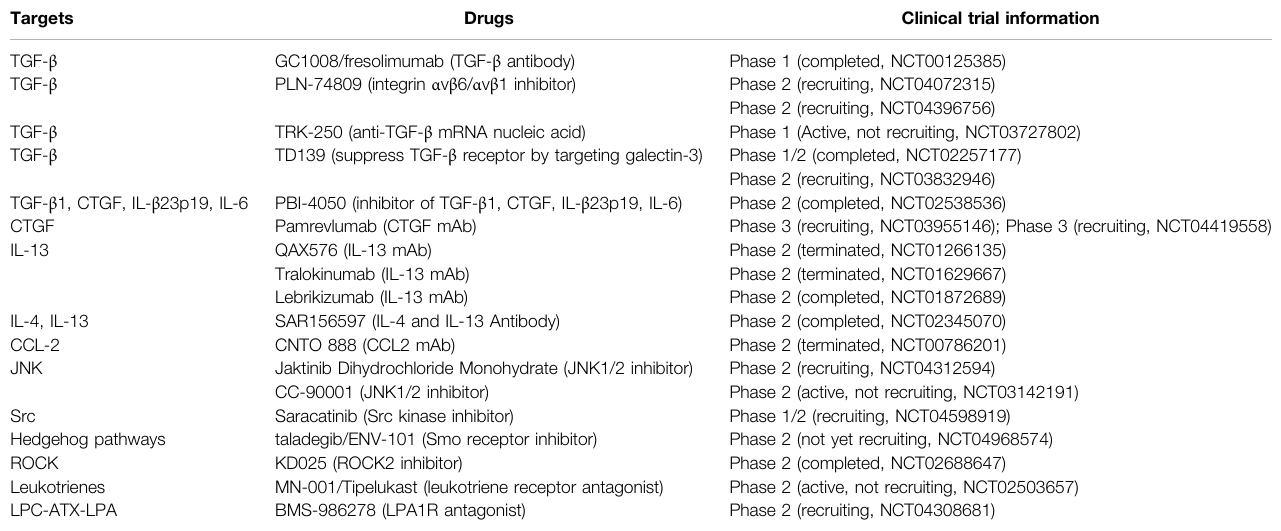
TABLE 2 | Emerging drugs targeting cytokine and growth factor pathways for IPF treatment in clinical trials.